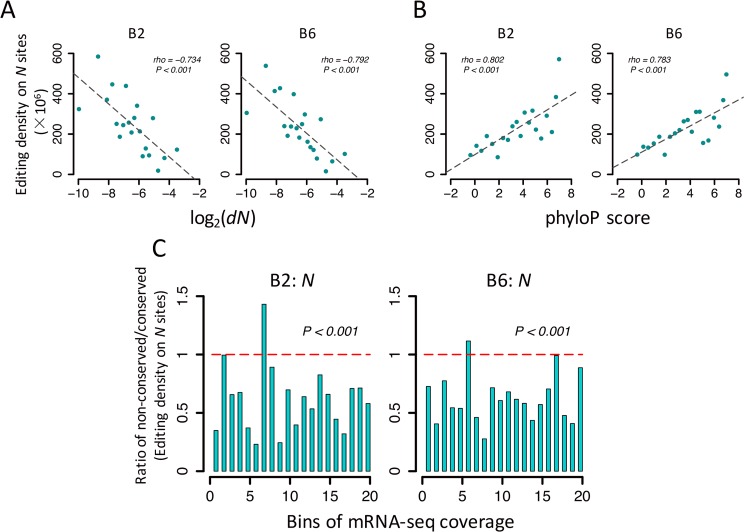
A-to-I editing increases mutation sequence space of evolutionarily conserved genes.(A) The editing density in the N sites is significantly inversely correlated with the dN value (between D. melanogaster and D. simulans) of the host genes. The genes expressed in brains are ranked with increasing dN values and divided into 20 bins (the x-axis, and lower dN means evolutionarily more conserved). The left and right panel is for 1- to 5-day female (B2) and male (B6) brains of D. melanogaster, respectively (Table 1). In each bin, the editing density (y-axis) is calculated by dividing the observed number of editing sites with the total number of adenosine sites that cause amino acid changes if edited. (B) The editing density in the N sites is significantly positively correlated with the phyloP score of the sites. All the nonsynonymous adenosine sites (cause amino acid changes if edited; ≥ 5X sequencing coverage) are ranked with increasing phyloP scores and grouped into 20 bins (x-axis, and higher phyloP score means evolutionarily more conserved). (C) The editing density of the N sites is significantly lower in the non-conserved compared to conserved sites after controlling mRNA-Seq coverage. All the nonsynonymous adenosine sites (cause amino acid changes if edited; ≥ 5X) are ranked with increasing sequencing coverage and binned into 20 categories (x-axis). Within each bin, we further divided the sites into two equal-sized subgroups based on the phyloP scores. The y-axis is the editing density of the non-conserved relative to the conserved subgroup in each bin.